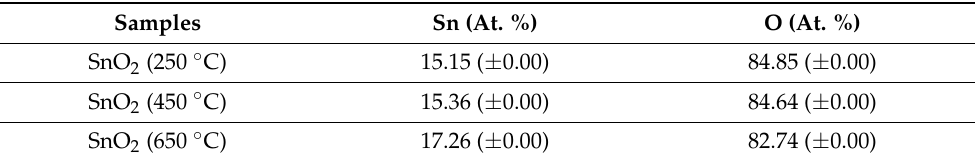
Figure 3. SEM images (left, ( a,c,e )) and EDS spectra (right, ( b,d,f )) of the SnO 2 nanoparticles formed at calcination temperatures of 650 °C, 450 °C, and 250 °C. Table 2. The composition of SnO 2 NPs estimated from EDS analysis. Here, errors represent elements other than Sn and